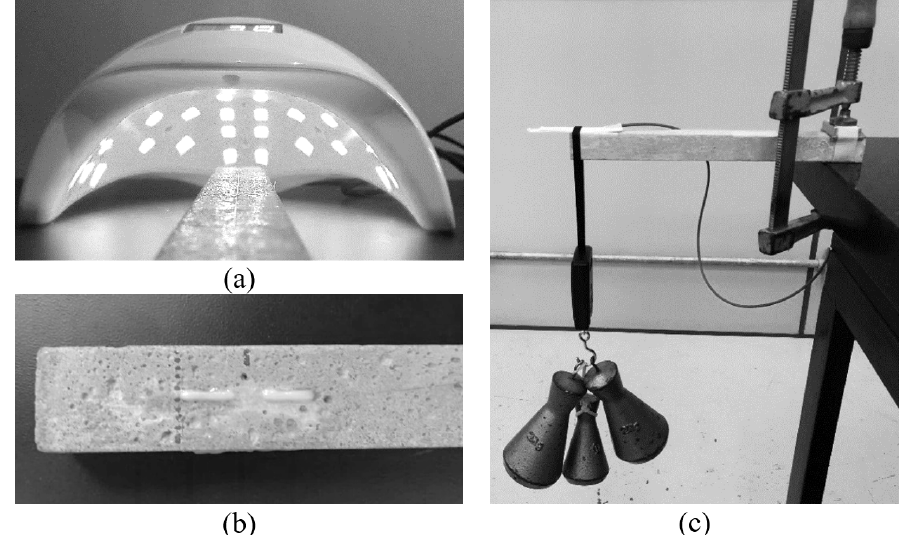
Figure 4. FBG instrumentation details: (a) resin UV curing, (b) final instrumentation and (c) cantilevered beam during static